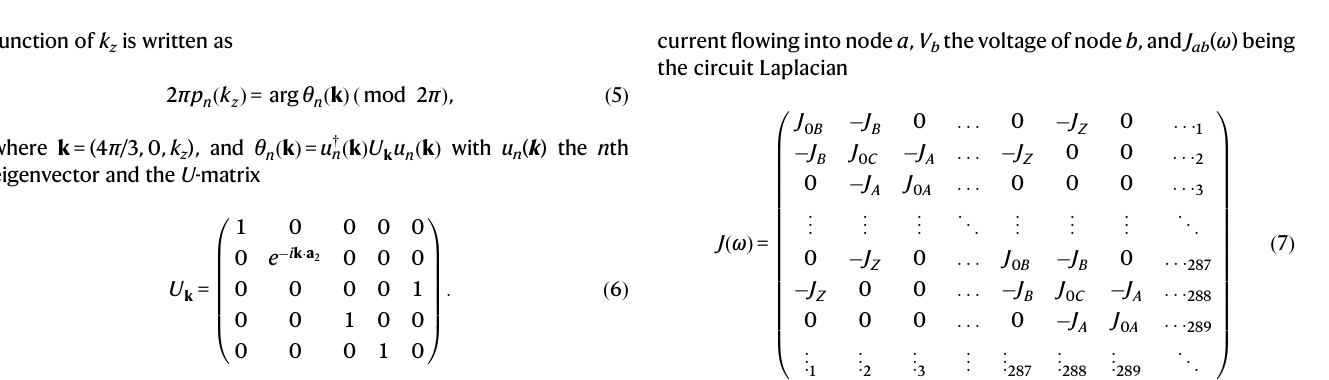
Fig. 2 | Finite-size circuit model. a Top view of a stacked 10-layer HK circuit with 2860 nodes. The green and blue segments represent the capacitors C A and C B , respectively, and each node is grounded by capacitors and inductors with the con fi gurations shown in the insets. The fi nite-size equilateral triangular structure withthezigzagedgewaschosenbecauseonerequiresauniformonsiteadmittance for all nodes of the breathing kagome block that appears upon squaring the